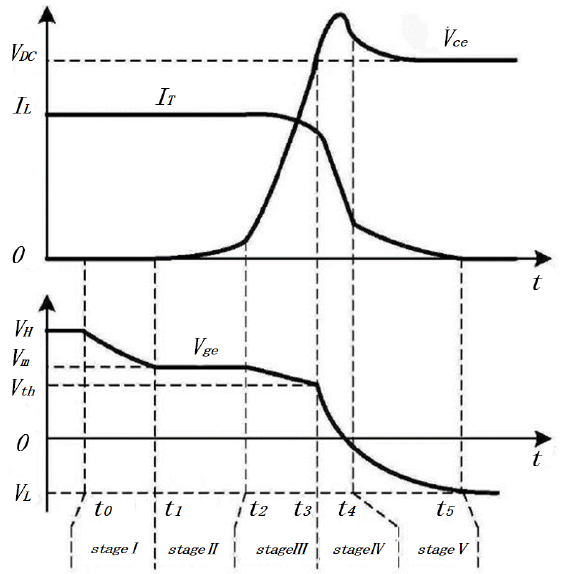
Figure 2. IGBT turn-off process